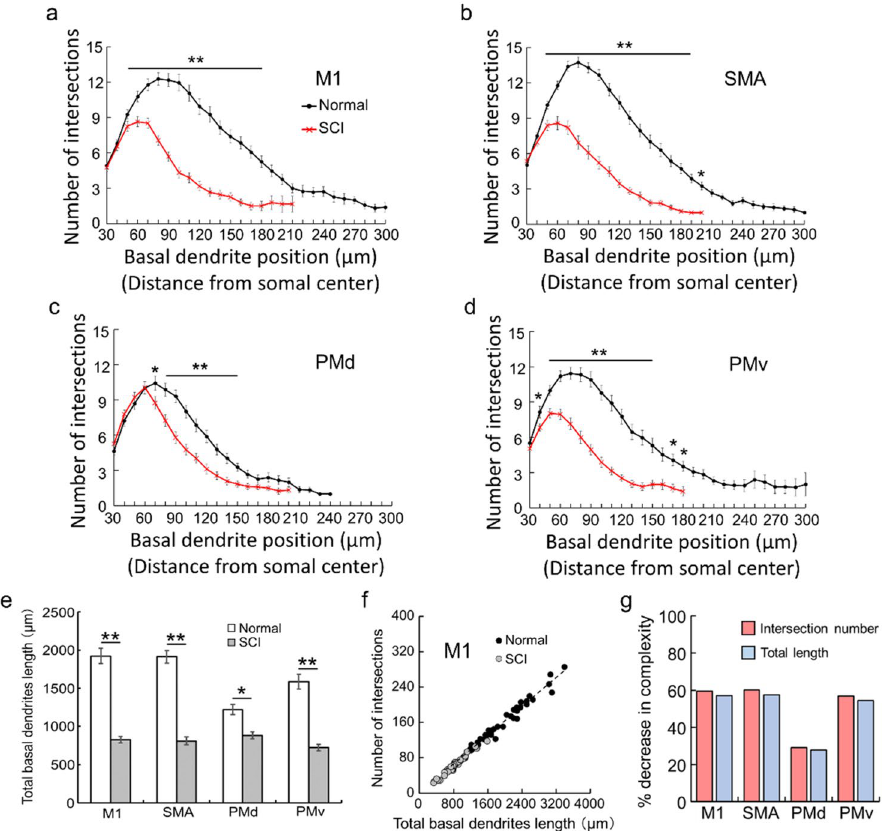
Figure 4. Reduced arborization post-SCI of basal dendrites of large layer V pyramidal neurons in frontal motor-related areas. ( a – d ) Histograms showing the number of intersections of basal dendrites at every 10-µm position for the M1 ( a ), SMA ( b ), PMd ( c ), and PMv ( d ) in the normal control (in black) and SCI model (in red). Error bars denote SEM. Two-way ANOVA with the Tukey–Kramer method. * p < 0.05, ** p < 0.01. ( e ) Histogram showing the total length of basal dendrites in the normal control (in white) and SCI model (in gray). ( f ) Correlations between the intersection number and the total length of basal dendrites in the M1 in the normal control (in black) and SCI model (in gray). ( g ) Histogram showing the decrease ratios of intersection number (in red) and total length (in blue) after